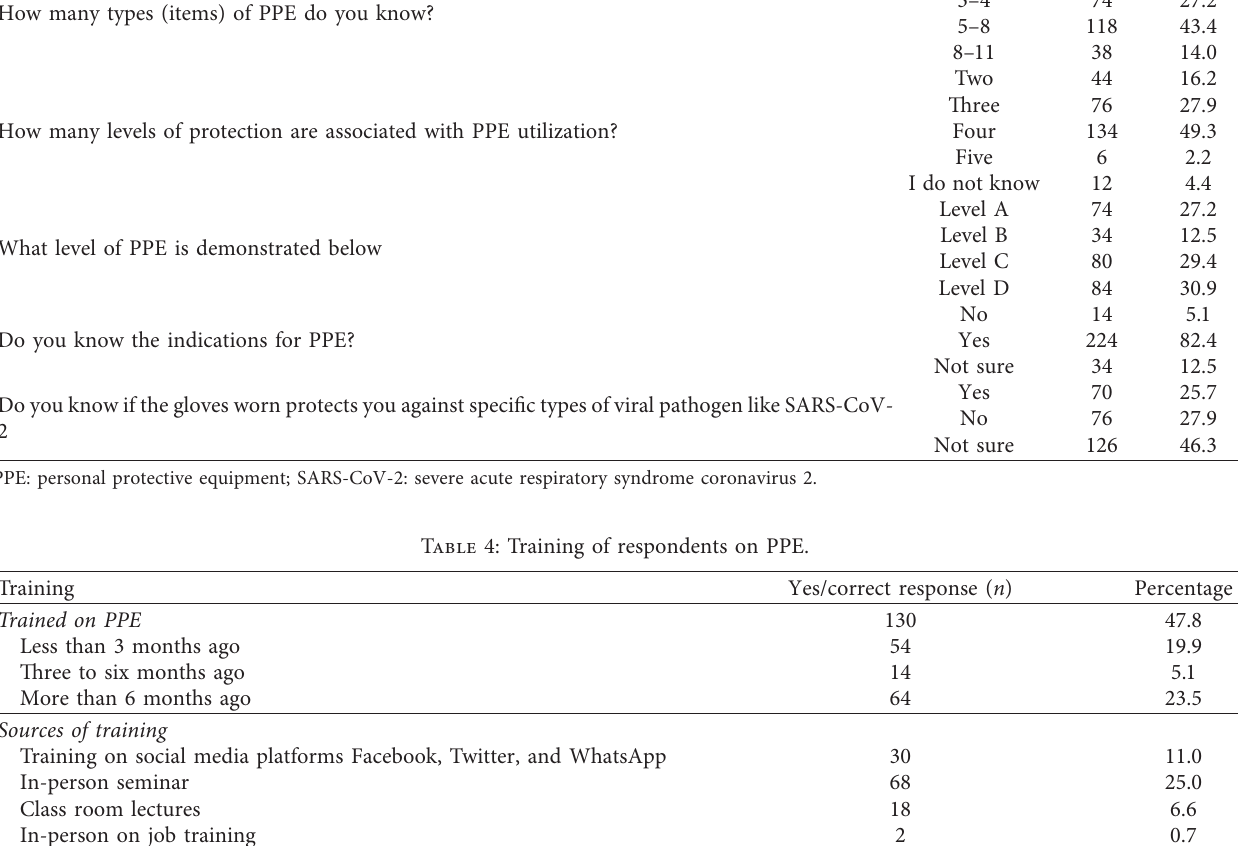
The only predictors of good knowledge of PPE was age.